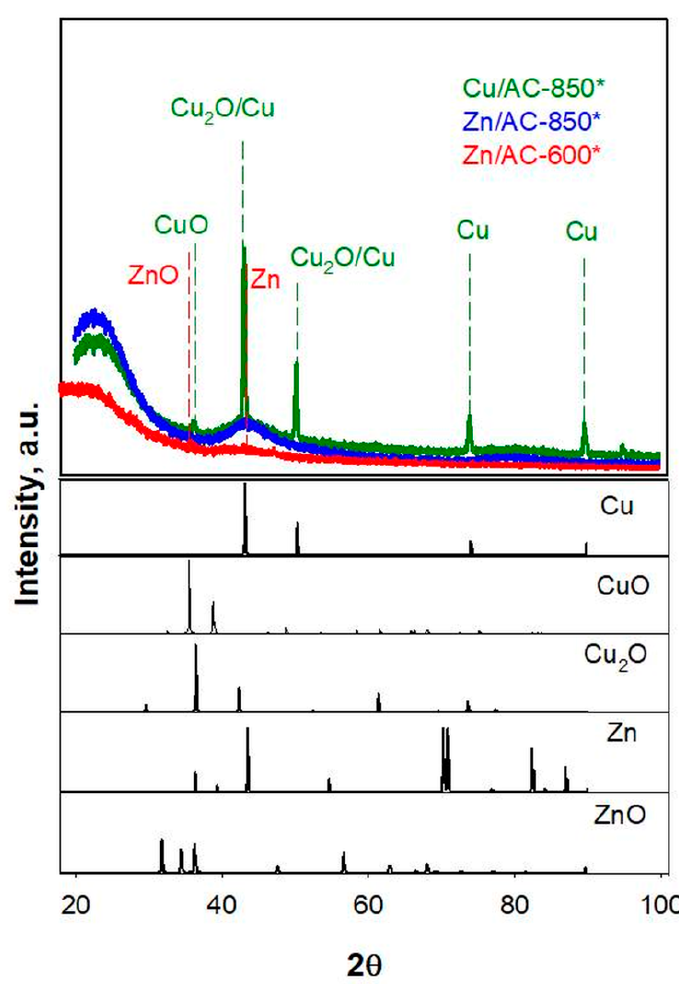
Figure 5. XRD patterns of Zn / AC-850*Zn / AC-600*and Cu / AC-850*. In the lower graph patterns of reference Zn (PDF 1-1244), ZnO (PDF 36-1451, Cu (PDF 4-836), Cu 2 O (PDF 5-667) and CuO (PDF 45-937) are reported.